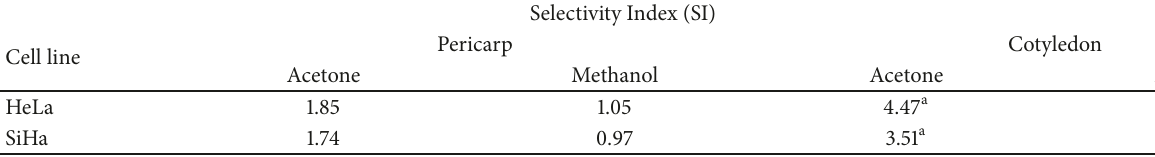
Table 2: Selectivity index (SI) of VDS fruit type SS extracts on HeLa and SiHa cells.